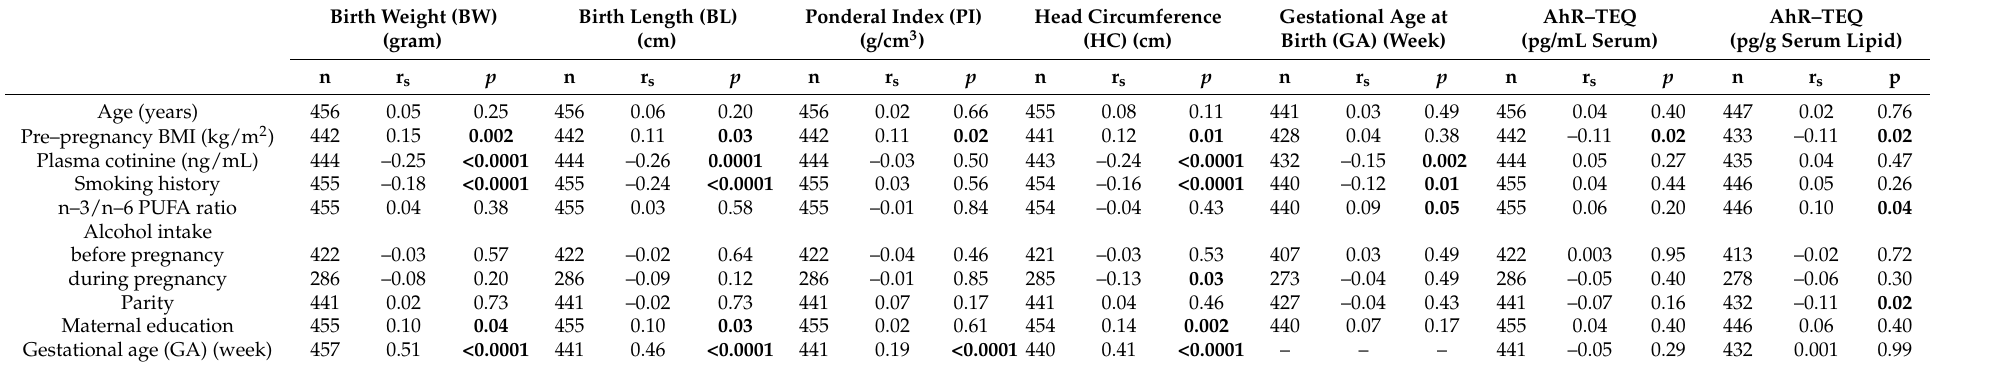
Table 5. Correlation of maternal characteristics with fetal growth indices and serum